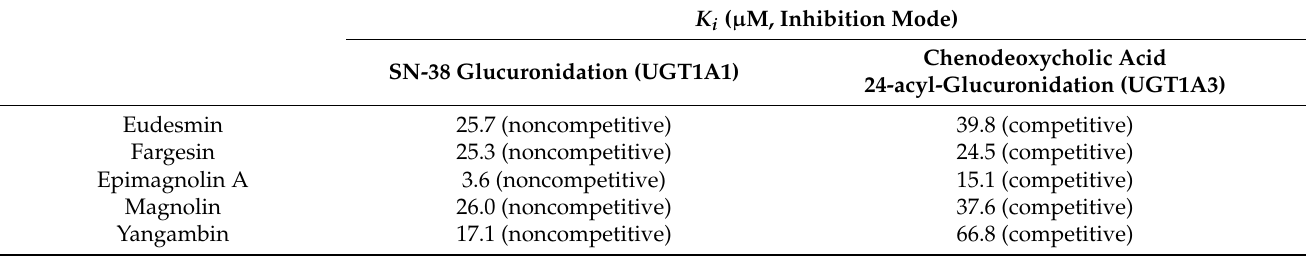
Figure 8. Dixon plots for the inhibitory effects of ( a ) eudesmin, ( b ) fargesin, ( c ) epimagnolin A, ( d ) magnolin, and ( e ) yangambin on UGT1A3-catalyzed chenodeoxycholic acid 24-acyl glucuronidation in pooled human liver microsomes. Each symbol represents the concentration of chenodeoxycholic acid: ● , 1 μ M; ○ , 2 μ M; ▼ , 5 μ M; ▽ , 10 μ M. The data are means ± SDs ( n = 3). Table 2. Kinetic parameters for the inhibition of eudesmin, fargesin, epimagnolin A, magnolin, and yangambin on UGT1A1 and UGT1A3 enzyme activities in pooled human liver